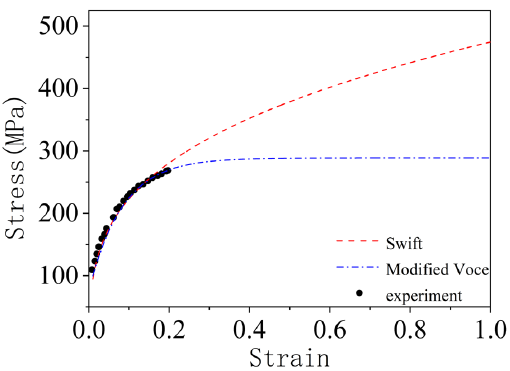
Figure 26. FLD of material 5754O based on Swift constitutive equation and MMFC instability crite-